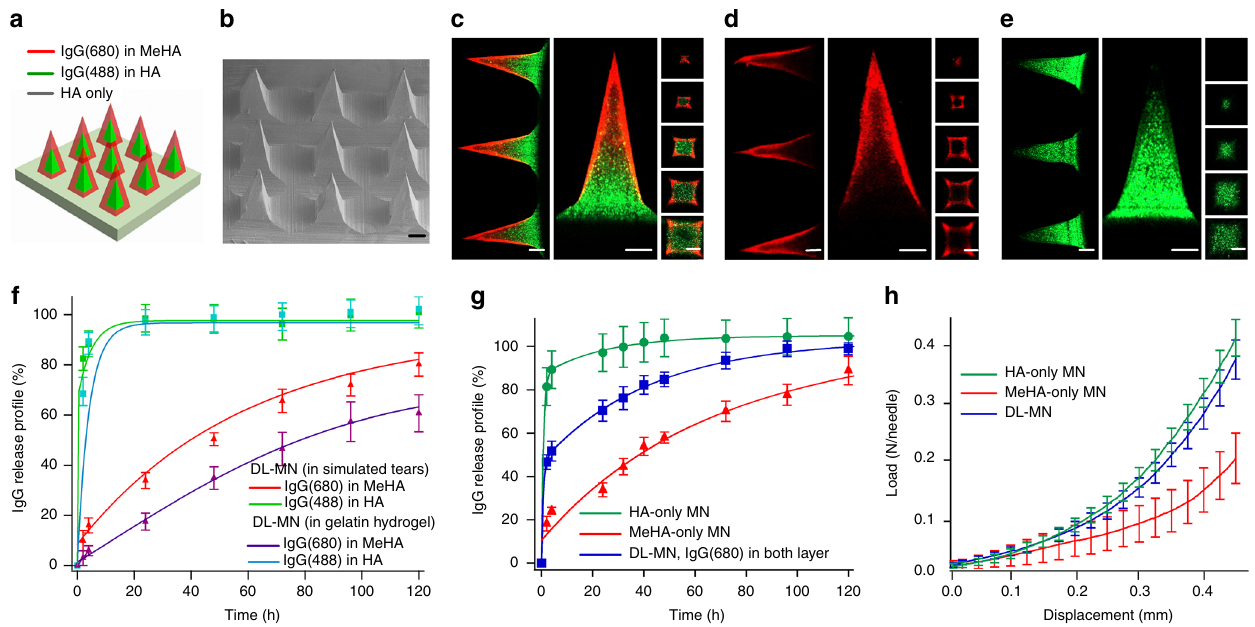
Fig. 3 Characterization of double-layered microneedles (DL-MNs). a , b Schematic and SEM images of a polymeric patch with an array of DL-MNs (the outer layer made of crosslinked MeHA and inner core made of HA). Scale bar = 100 µ m. c – e Representative confocal images of c DL-MNs loaded with immunoglobulin G conjugated with Alexa Fluor: IgG(680) (red colour) in outer layer and IgG(488) (green colour) in inner core, d DL-MNs with IgG(680) in outer layer only, e DL-MN with IgG(488) in inner core only. Scale bars = 100 µ m. f In vitro fast and slow release pro fi les of DL-MNs in simulated tears or gelatin hydrogel (37 °C). IgG(680) was loaded in outer layer and IgG(488) was loaded in inner core ( n = 3). g In vitro release pro fi les of IgG(680) from HA-MN, MeHA-MN or DL-MN in phosphate buffer saline (PBS) (37 °C) ( n = 3). IgG(680) was loaded in both layers of DL-MN. h Mechanical compression test of HA-MN, MeHA-MN and DL-MN ( n = 4). The data represents as mean value, and error bars indicate SEM (mean ± SEM). n represents the number of samples for each group